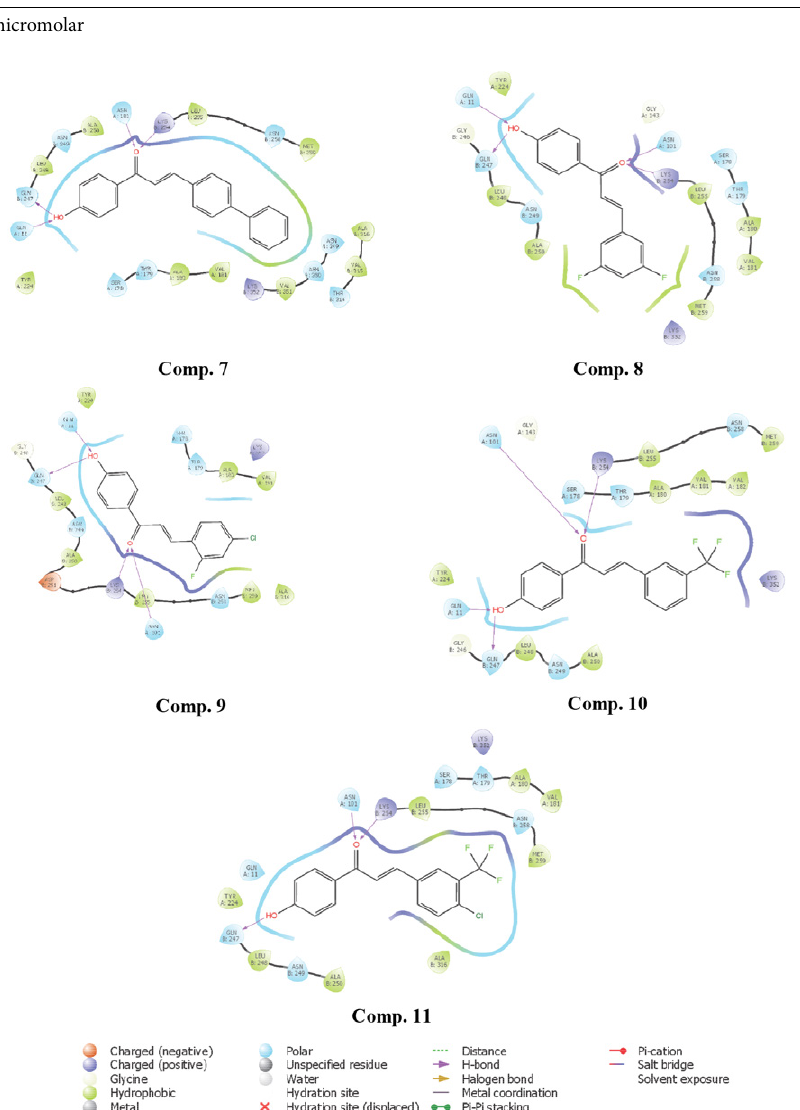
Figure 2. 2D interaction diagram for compounds 7 – 11 at the tubulin binding